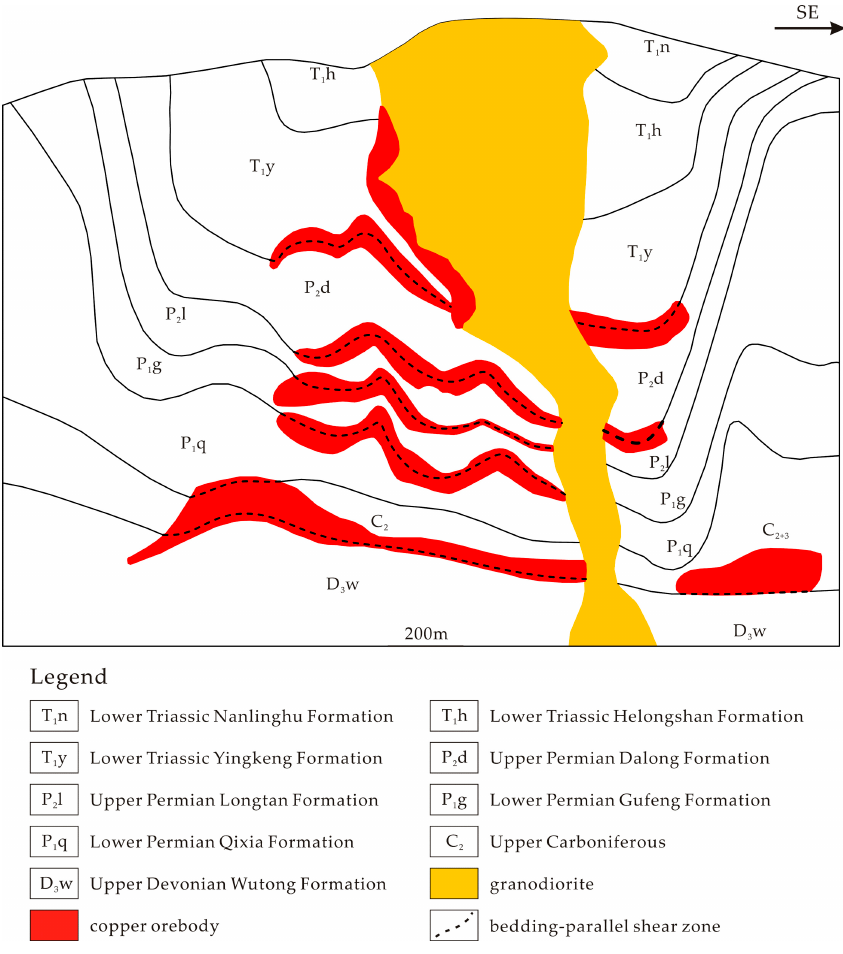
Figure 20. Typical cross-section of Shizishan ore field showing the characteristic stratabound skarn orebodies hosted in the folds, modified from [43].